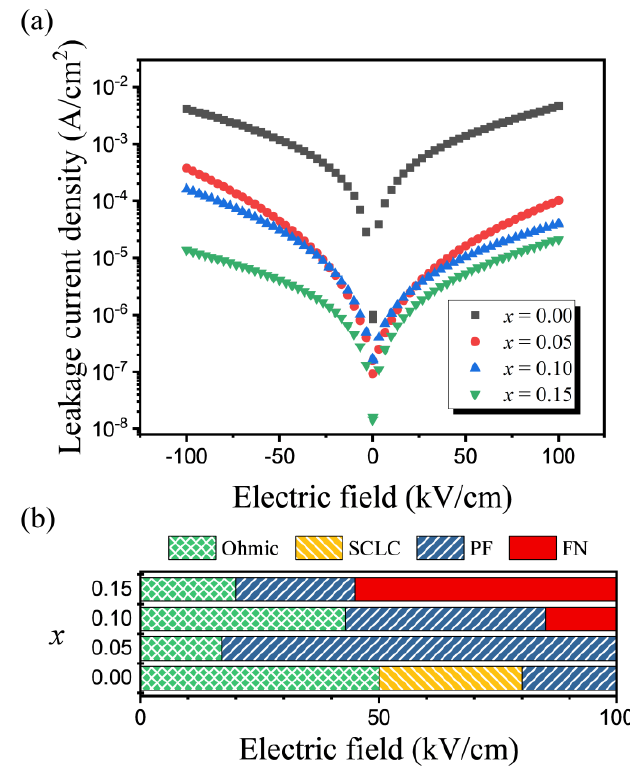
Figure 5. ( a ) Leakage current density and ( b ) leakage mechanism of Bi 1 − x Gd x FeO 3 ( x = 0.00, 0.05, 0.10, and 0.15) films.